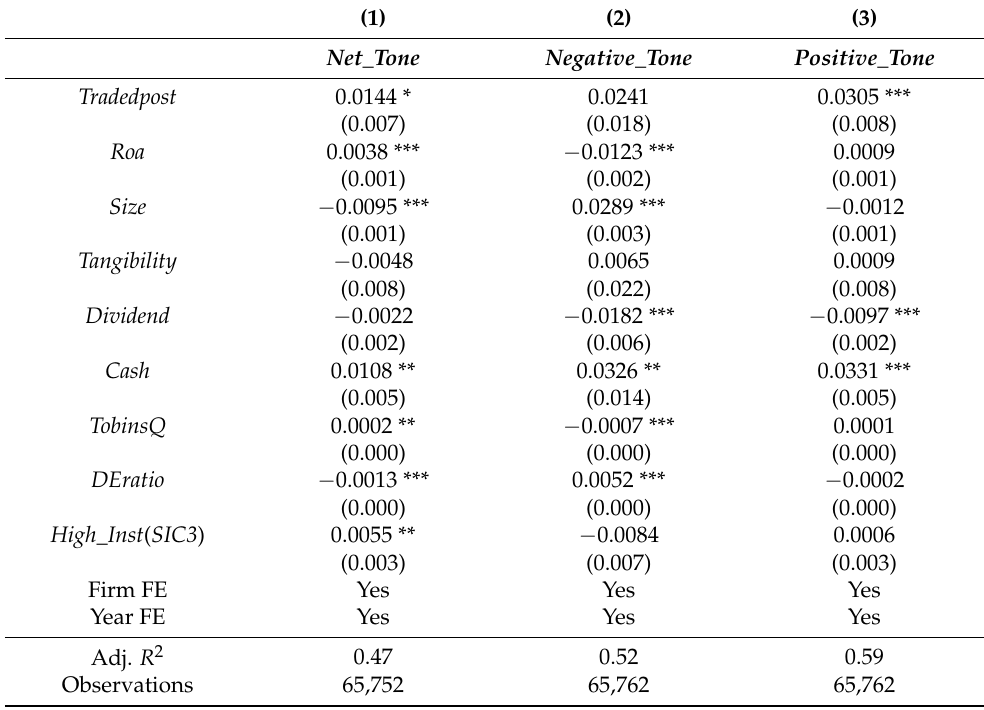
Table 7. CDS initiation and 10-K tones. This table reports the results for an alternative version of model (3) using tone measures for a firm’s 10-K filings. Standard errors were clustered by firms and reported in parentheses. Lagged firm-specific controls and firm and year fixed effects are included in all specifications. Coefficients with *, **, or *** indicate a significance level of 0.10, 0.05, or 0.01, respectively. For detailed definitions of variables, please refer to Appendix A Table